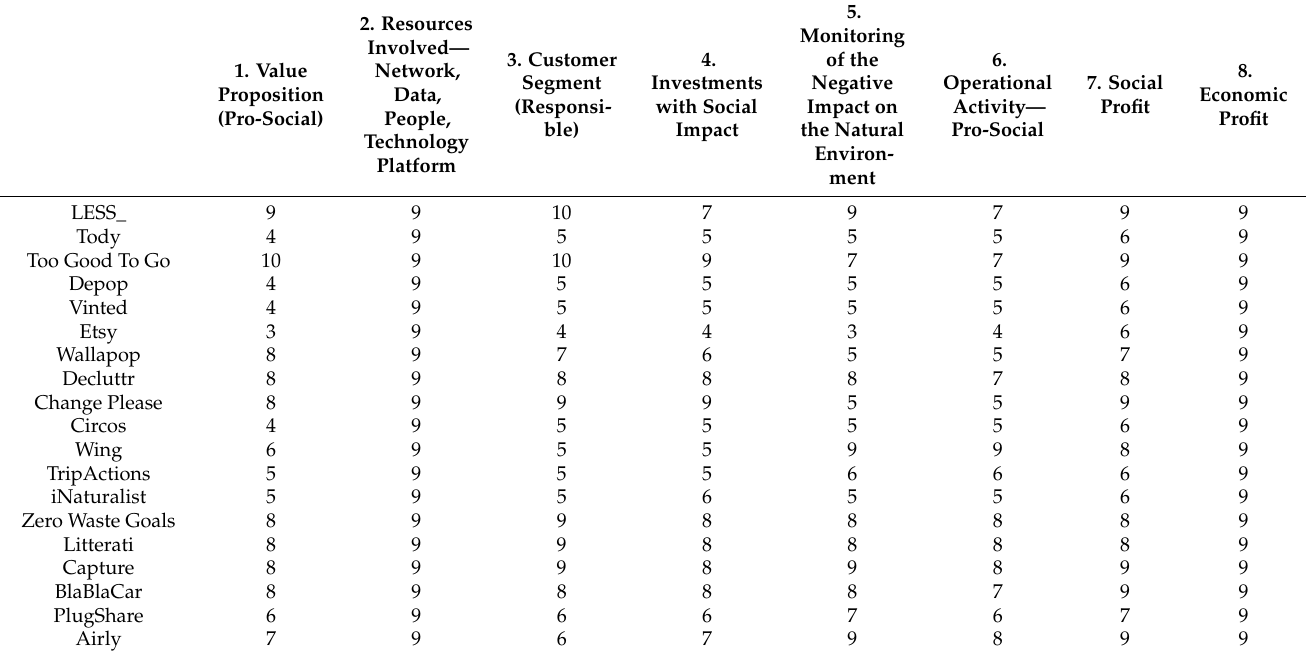
Table 6. Summary of rankings obtained (own